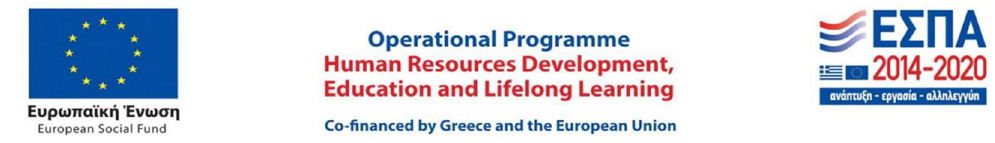
inclusion complexes. Table S2. Conformational characteristics of the two β -CD host molecules in the PN/ β -CD structure. Table S3. Conformational characteristics of the DM- β -CD host molecule in the PN/DM- β -CD structure. Table S4. Conformational characteristics of the two TM- β -CD host mole- cules in the PN/TM- β -CD structure. Table S5. H bond analysis for the two encapsulated PN mole- cules (PN_1 and PN_2) in their complex with four β -CDs during the 12ns MD